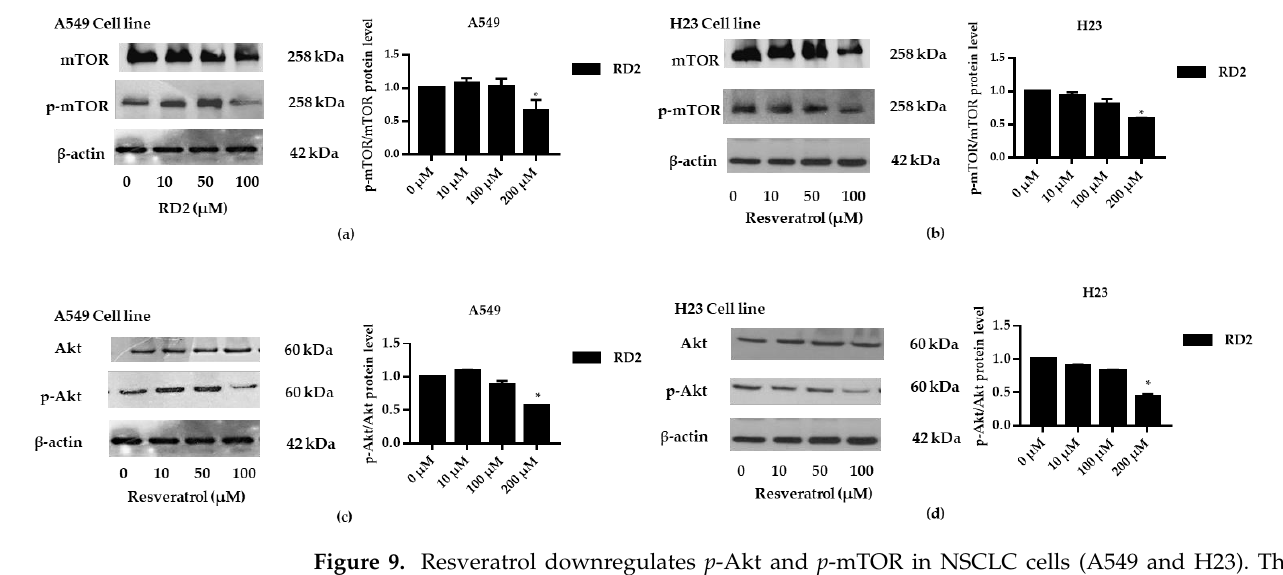
Figure 9. Resveratrol downregulates p -Akt and p -mTOR in NSCLC cells (A549 and H23). The cells were treated with resveratrol (0–100 µ M) for 24 h. ( a – d ) Western blot analysis was performed to measure the p -Akt/Akt-related proteins. β -Actin protein was evaluated to confirm the equal loading of each protein sample. Densitometry of each protein level was calculated and the results are presented as a relative protein level. Relative protein levels were quantified by densitometry. Data are represented as the mean ± SEM. * p < 0.05, when compared with the control group.